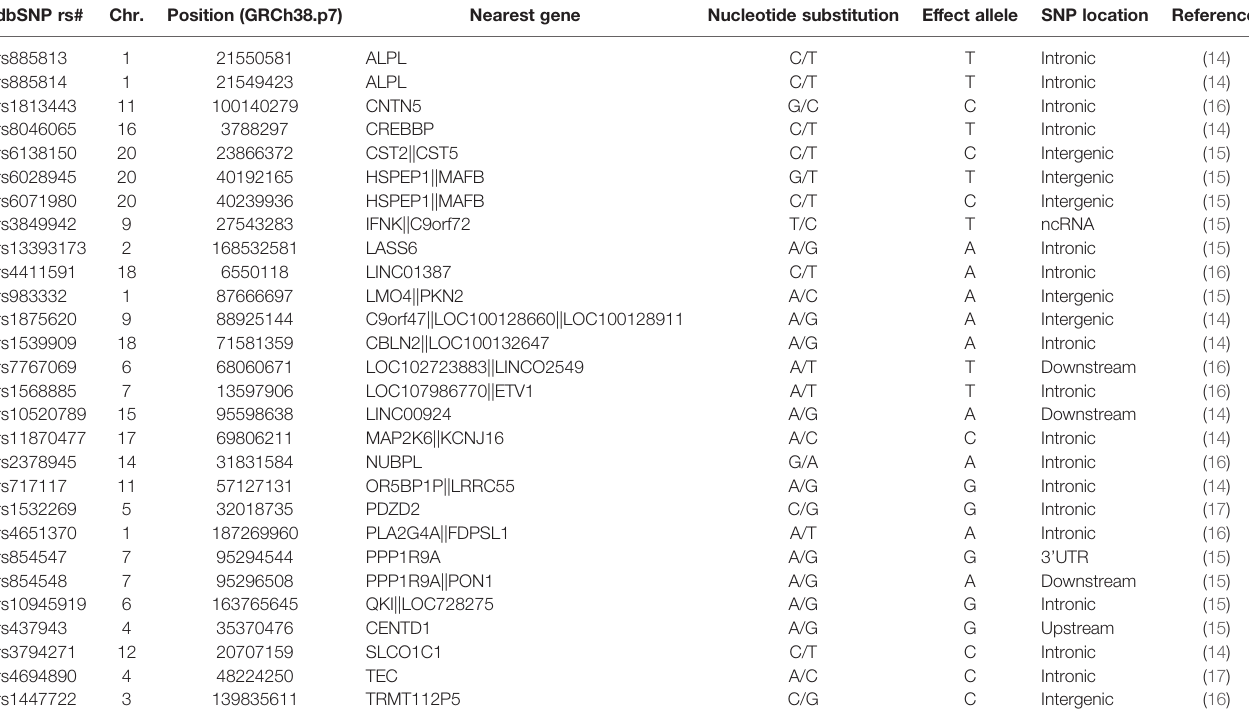
TABLE 2 | Selection of GWAS-identi fi ed SNPs for response to anti-TNF drugs. dbSNP rs# Chr. Position